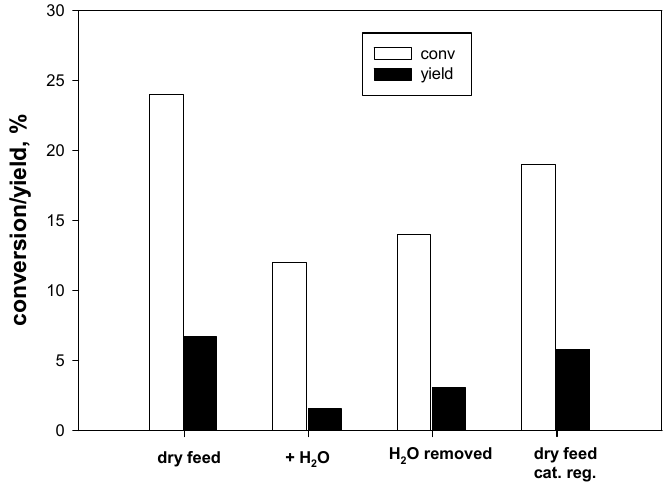
Figure 8. Effect of 2 vol. % H 2 O addition to the feed (for a total of 9 h) and removal onto the ethanol conversion and butanol yield obtained with a Ru/MgO/ γ -Al 2 O 3 catalyst tested at T = 350 °C and GHSV = 330 h − 1 . The fourth test was performed under dry conditions after catalyst regeneration for 2 h at 600 °C in air.